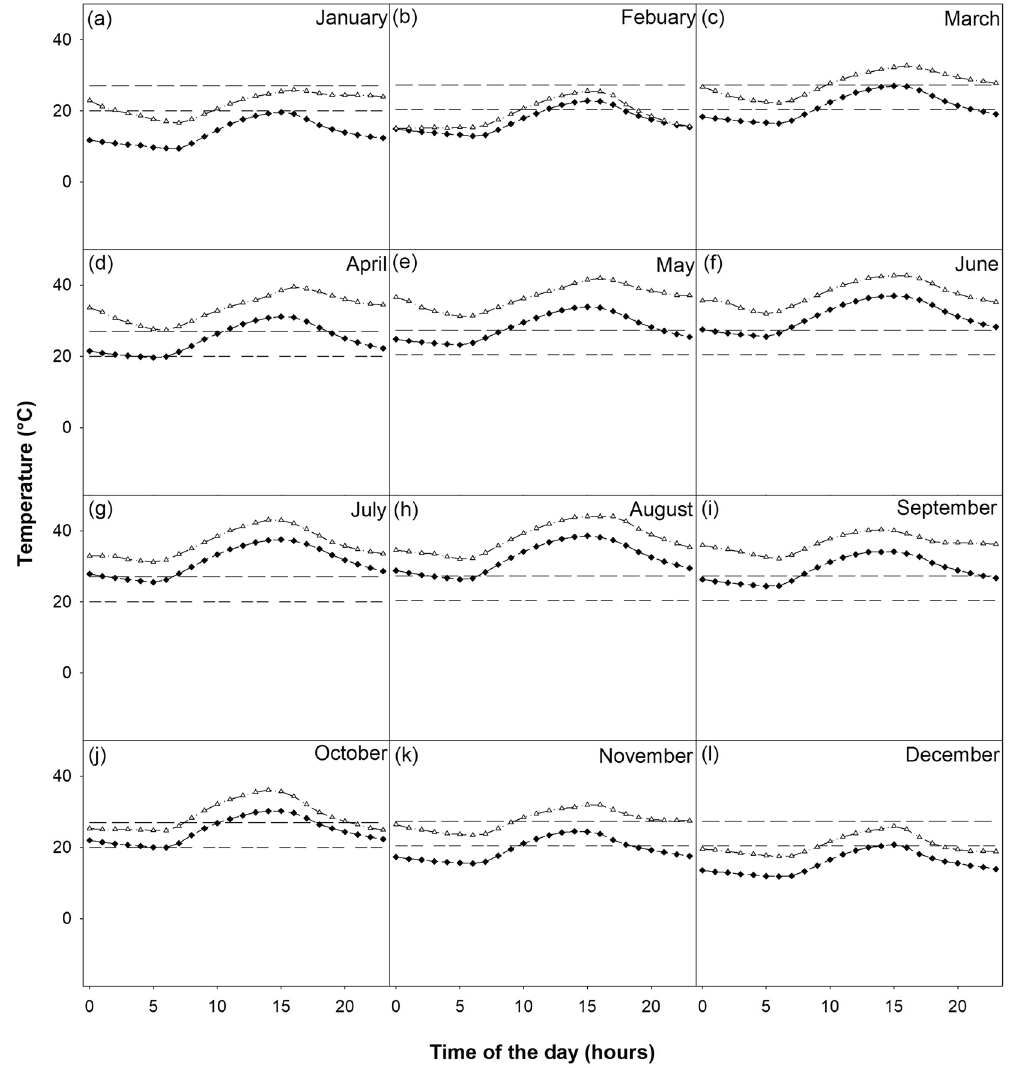
Figure 6. South Texas Plains ecoregion hourly mean temperature by month between 2010 and 2019 (black diamonds) and projections to 2080 (white triangles). The double dashed line (20 °C) represents maximum clear ambient temperature and the single dashed line (27 °C) represents the maximum cloudy ambient temperature for deer